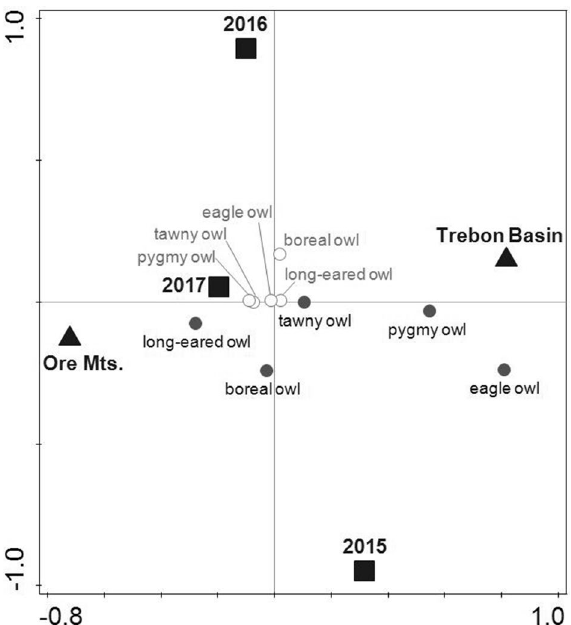
Figure 3. The effect of the study area (Ore Mts. and Trebon Basin, black triangle) and year (2015–2017, black square) on the distribution of owl species (boreal, tawny, pygmy, long-eared, and eagle owls) based on the vocal activity of owls. The presence (grey circle, black front) and the absence (white circle, grey front) of individual owl species are shown. The canonical correspondence analysis (CCA) was used. The first and second ordination axes together explained 94.7% of the variability.